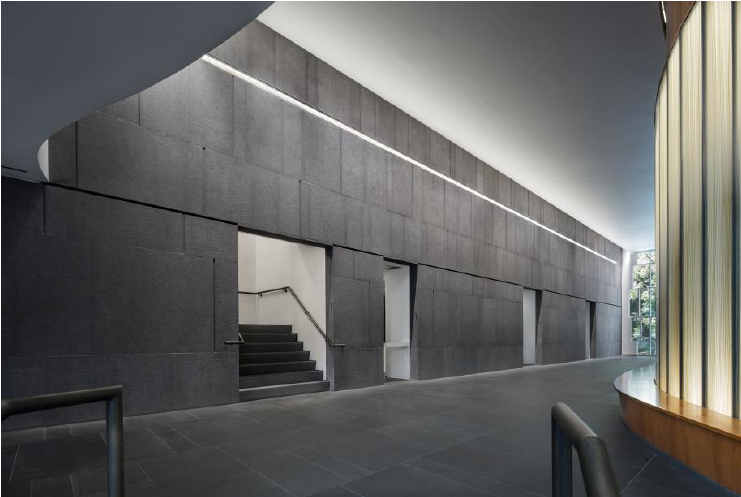
Figure 4. Lobby, Stone wall on south side of lobby, looking west. Photo David Sundberg/ESTO. Cedar of Lebanon—albeit obtained in Italy—veneers the main entrance doors and the lobby (Figure 5).